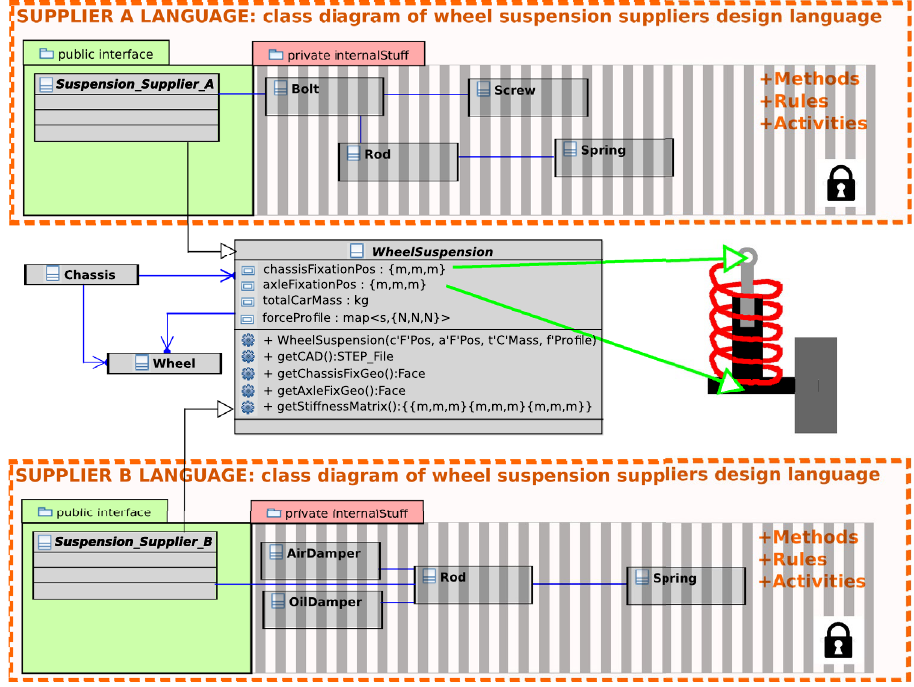
Fig. 15 Collaboration and divi- sion of labor by an embedding and composition of external design languages. The